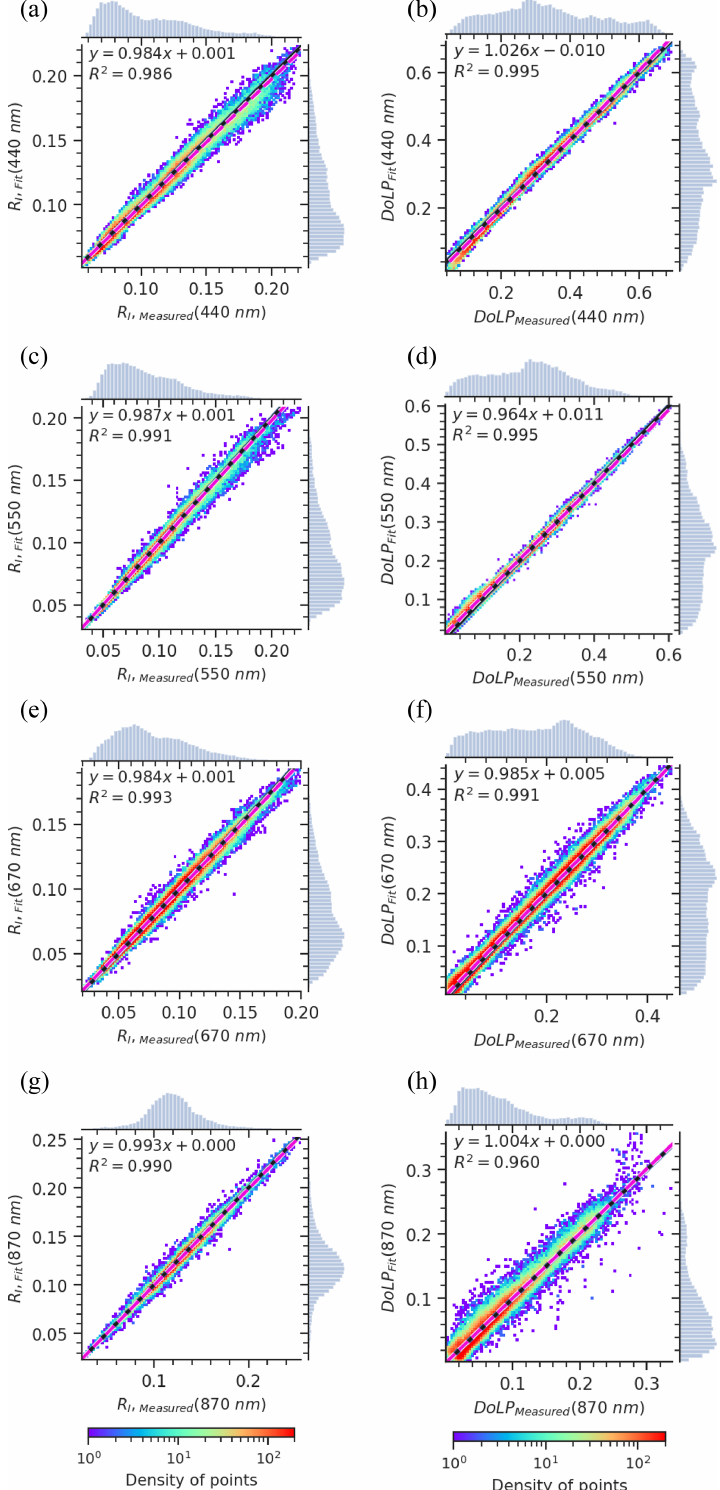
Figure 12. Scatter density plot for AirHARP measurement variables and GRASP fit for the scene in Fig. 9. 1 : 1 line (black solid line), OLS regression line (magenta dashed line), the OLS fit parameters and correlation ( R 2 ) are also reported in the same graph. For each plot, the histogram of measurement and GRASP fit for R I and DoLP are plotted on the top and right axes,